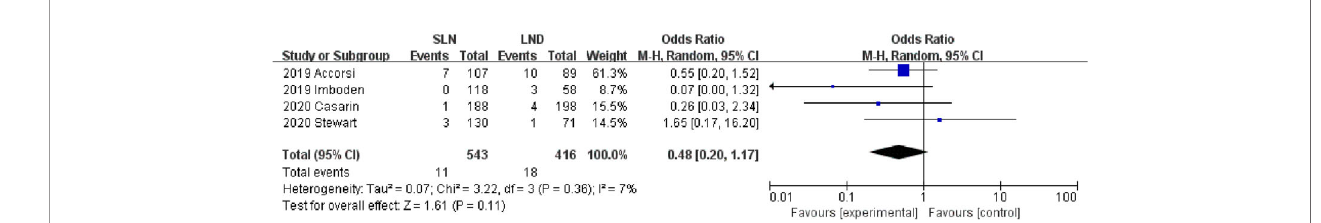
FIGURE 4 | Meta-analysis of intra-operative complications.